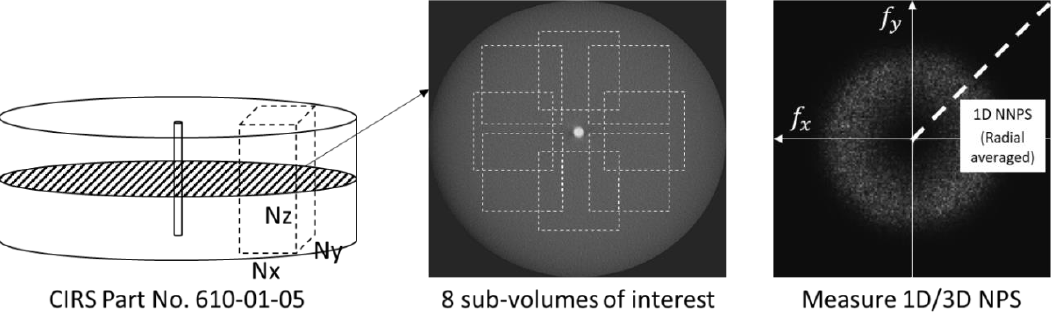
Figure 4. A schematic illustration for deriving 3D NPS.